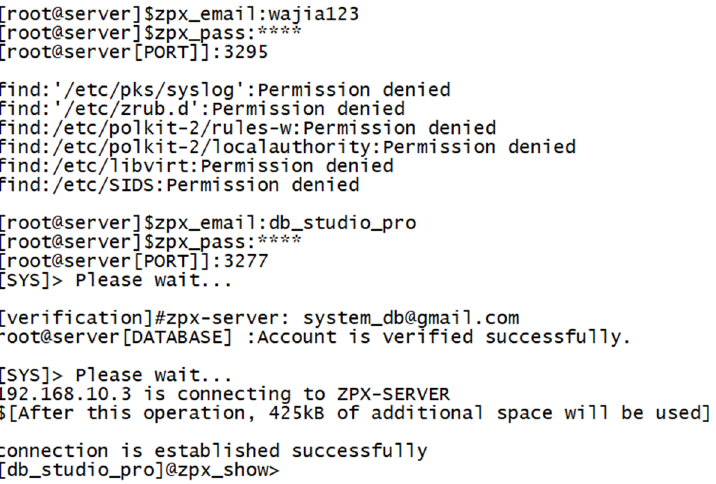
Figure 4. Accessibility of cloud server in the second attempt.